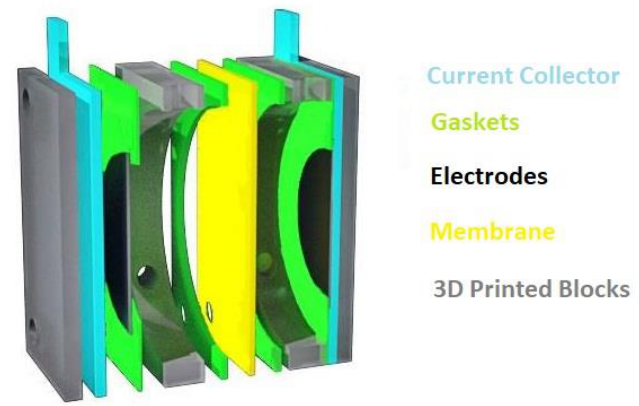
Figure 12. Scheme of homemade electrolyzer obtained by 3D printer.